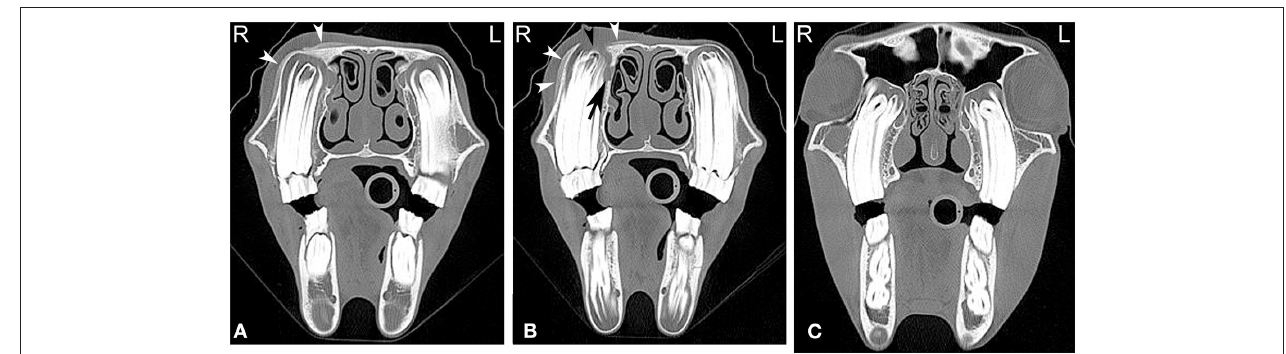
FIGURE 3 | Maxillary soft tissue swelling with “caps” and sinusitis. Transverse computed tomography images of the head at the level of the premolar teeth displayed in a bone window of a 3-year and 11-month-old Miniature horse with a hard swelling rostral to the right eye. CT images at the level of the fourth premolar teeth (A,B) show deciduous cheek teeth remnants (“caps”) on all premolar teeth. Dorsal to the right fourth maxillary premolar tooth (Triadan 108), there is a focal area of increased soft tissue thickening with loss of the right maxillary bone (black arrowhead) dorsal to the apex of the right fourth maxillary premolar tooth (Triadan 108) and adjacent periosteal remodeling of the maxillary bone (white arrowheads). Additionally, widening of the periodontal space (black arrow), osteitis and small amounts of gas associated with the apex of this tooth are present, consistent with apical infection. CT image at the level of the third maxillary molar teeth (C) , whose alveoli extend into the caudal maxillary sinuses, decreasing the size of their lumina. L, left; R, right.